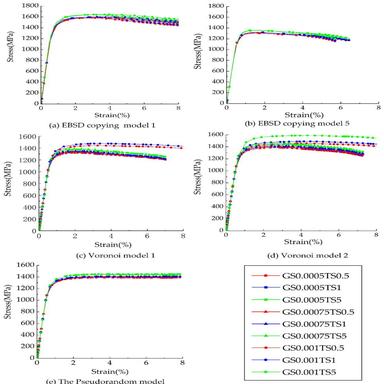
Σ Σ σ − ε curve comparisons of grain scale RVE models in different cases (GS means approximate global size of mesh, TS means tension speed).